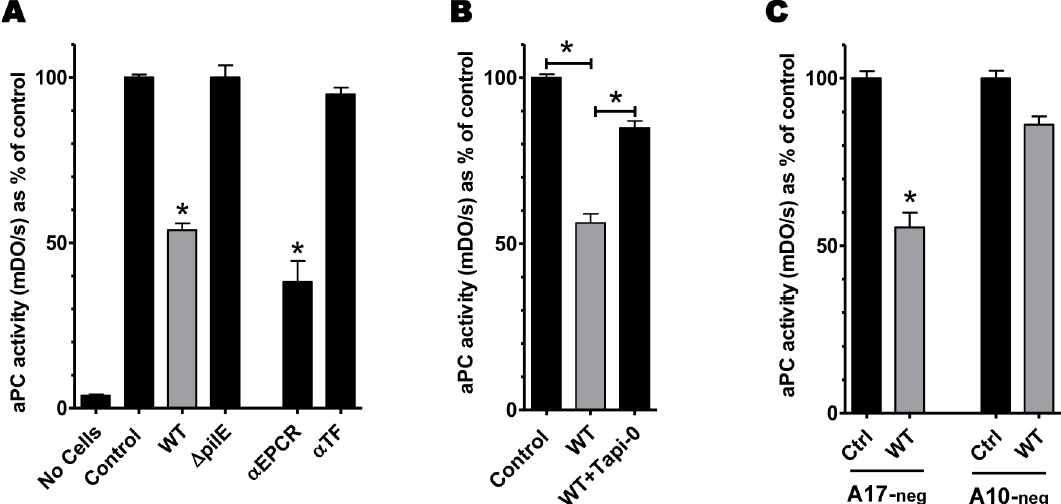
Fig 7. aPC generation by endothelial cells is impaired upon infection by N . meningitidis . After infection or antibody treatment, endothelial cells were washed and incubated for 30 min with Protein C and thrombin. The amount of aPC generated was determined through its proteolytic activity against a chromogenic substrate. The same experimental procedure was applied to an empty well without cells to assess the spontaneous degradation of the chromogenic substrate (no cells bar). ( A ) HDMEC were infected with either a wild type or Δ pilE strain for 4 hours. Cells were also treated for 10 minutes with an antibody blocking EPCR-PC interactions (clone RCR-252, 10 μ g/mL) or a control antibody (directed against tissue factor, 10 μ g/mL). Data are means (+/-SEM) of % of aPC activity compared to that of non-infected cells from 3 independent experiments. (cid:3) :p < 0.001 compared to control. ( B ) HDMEC cells were infected for 4 hours with a WT strain in the presence or absence of Tapi-0 (25 μ M). Data are means (+/-SEM) of % of aPC activity compared to that of non-infected cells from 3 independent experiments. ( C ) ADAM17-negative or ADAM10-negative hCMEC/D3 cells were infected for 4 hours with a WT strain. Data are means (+/-SEM) of % of aPC activity compared to that of non-infected cells from 3 independent experiments. (cid:3) : p < 0.0001 compared to